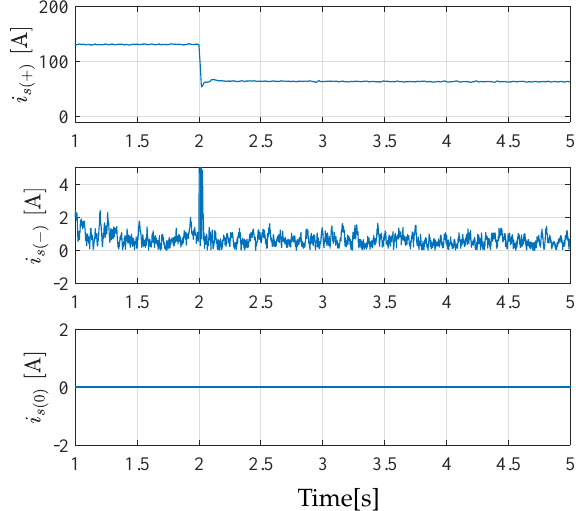
) ), and zero sequence −